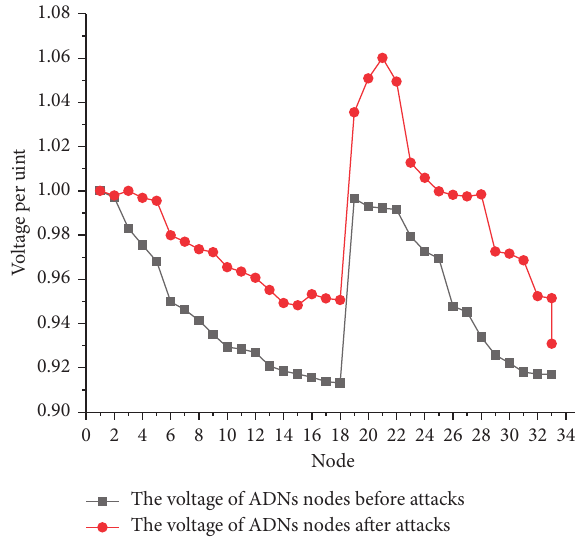
Figure 9: The voltage value of ADNs’ nodes before and after A II